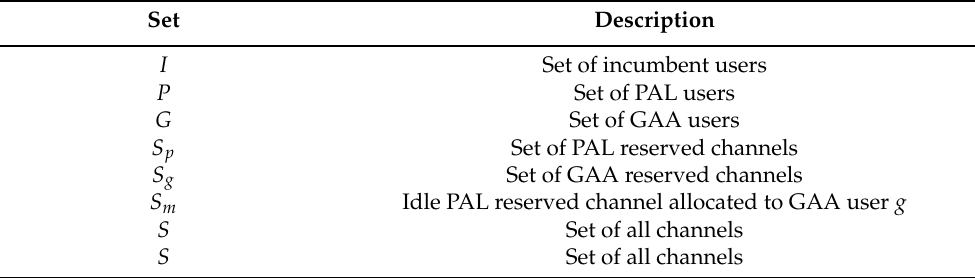
Table 1. Notations